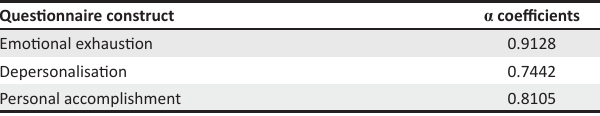
TABLE 2: Cronbach’s alpha coefficients for the subscales of the Maslach Burnout Inventory. Questionnaire